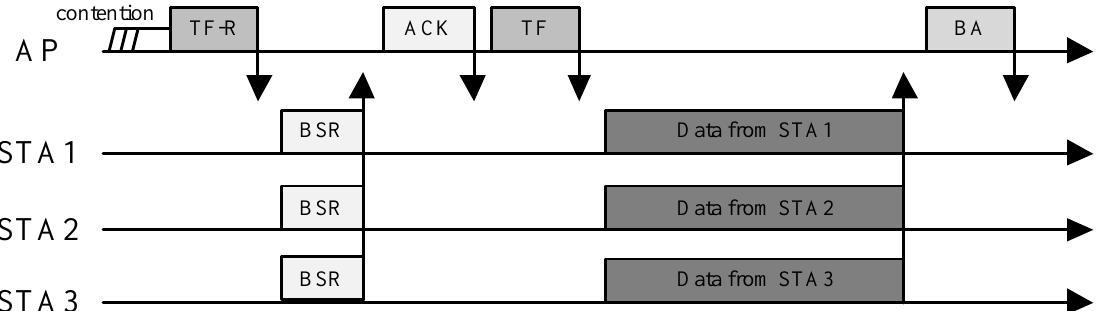
Figure 1. Example of an UL OFDMA transmission in 802.11ax. The AP first collects the data transmission intention from STAs via buffer state requests (BSR), and then schedules an UL OFDMA transmission. The actual UL transmission of STAs is initiated with the subsequent TF sent by the